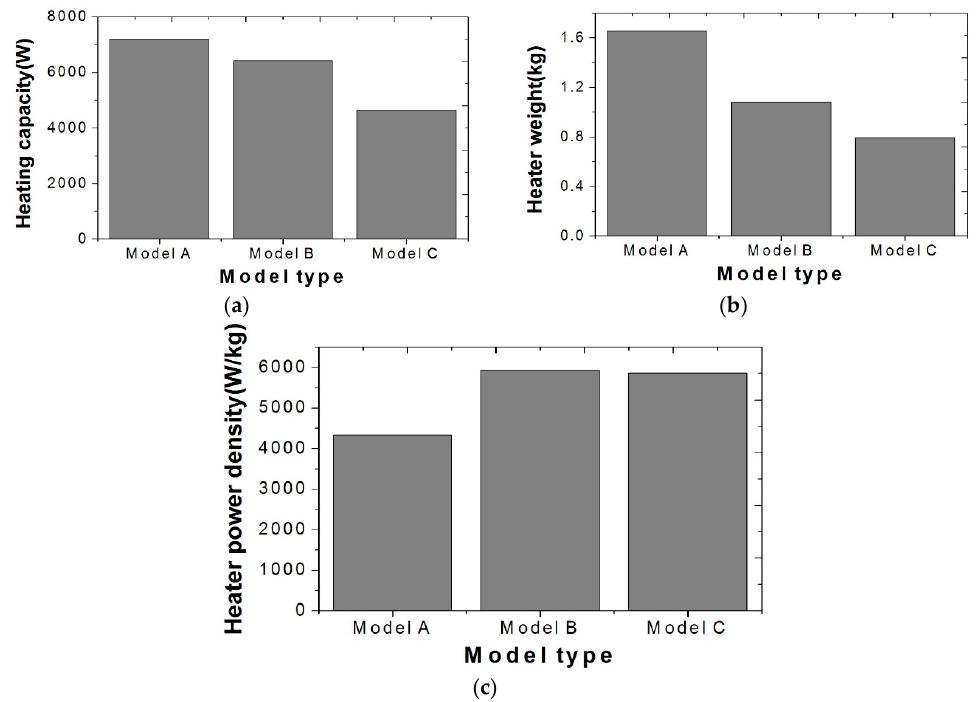
Figure 7. Result of CFD analysis for heater for each model, ( a ) heating capacity, ( b ) weight, ( c ) heater power density.